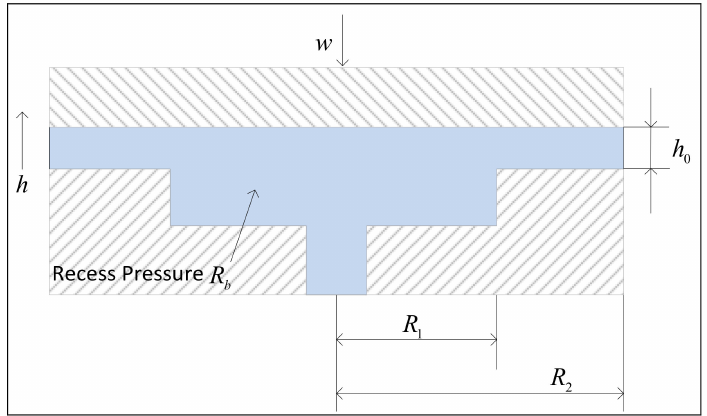
Figure 1. Hydrostatic thrust